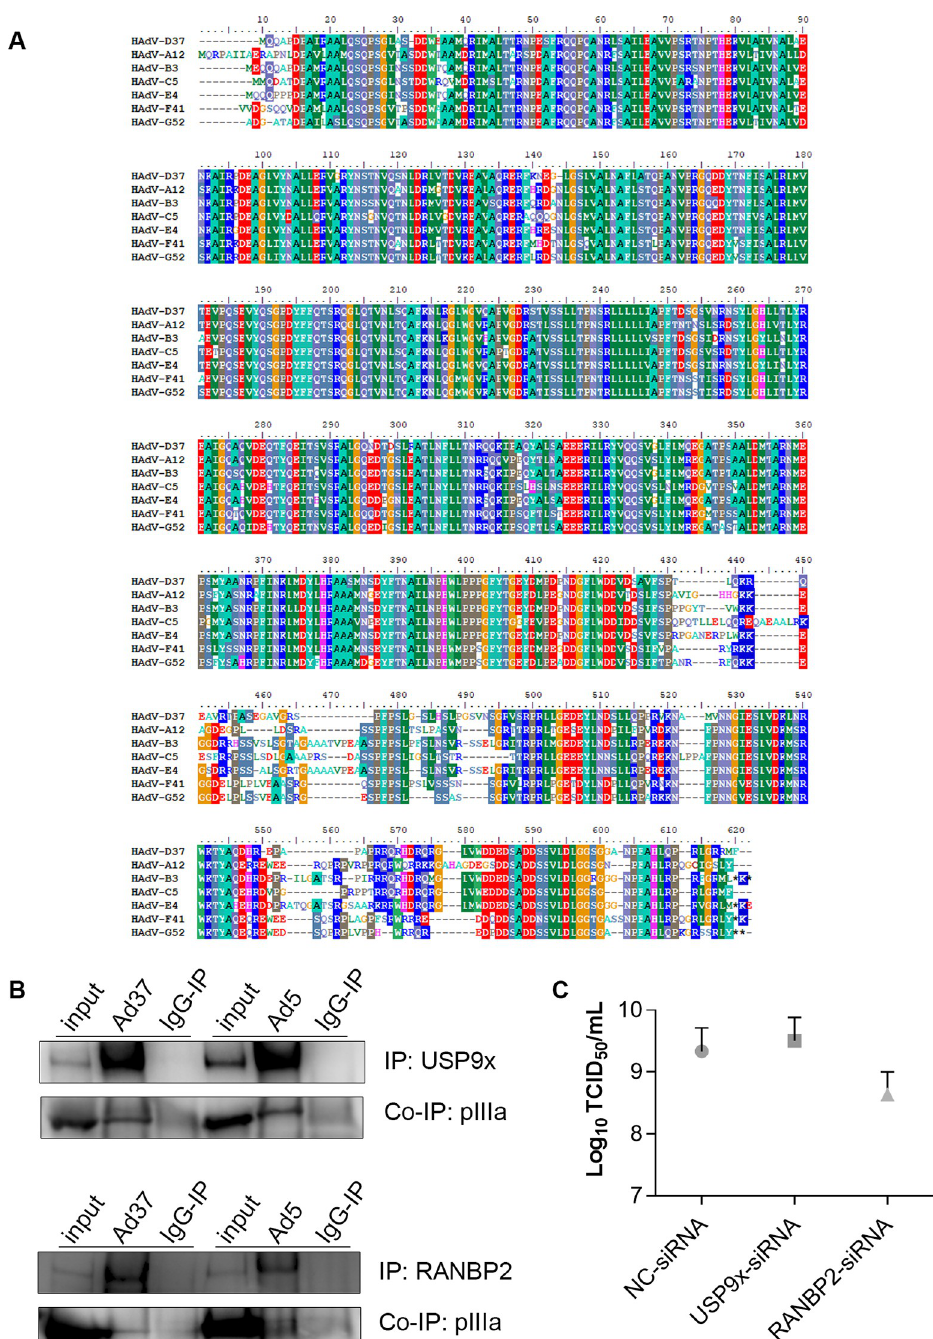
Fig 9. Identified pIIIa-host interactions are crucial across different HAdV species. (A) Multiple sequence alignment of representative pIIIa amino acids across HAdV A-G species using BioEdit. Sequence conservation across types are color coded. (B) Co-immunoprecipitation of HAdV-D37 and HAdV-C5 infected cells (MOI of 1 and 5, respectively, 24 hpi) show pIIIa-USP9x and pIIIa-RANBP2 interactions for both viruses. (C) HAdV-C5 viral replication in USP9x and RANBP2-siRNA treated HEK293 cells at an MOI of 5 and 24 hpi. Data shown are mean ± standard deviation for 3 replicates ( P > 0.05 by unpaired t-test, two-tailed).